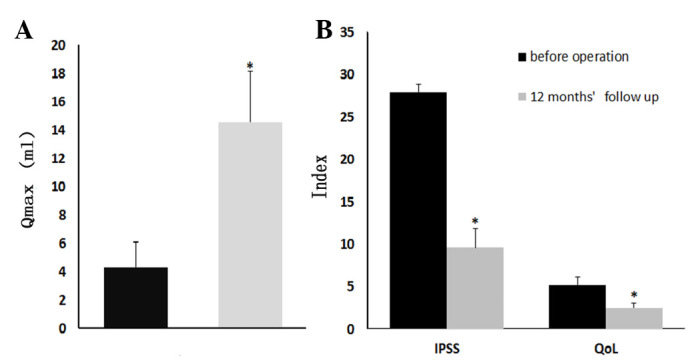
Statistical analysis result of patients with prostate volume over 80 ml. (A) comparison of maximum urinary flow rate before operation and 12-month follow-up. (B) comparison of IPSS and Qol (quality of life) index before operation and 12-month follow-up. *P<0.05 compared with value before operation.